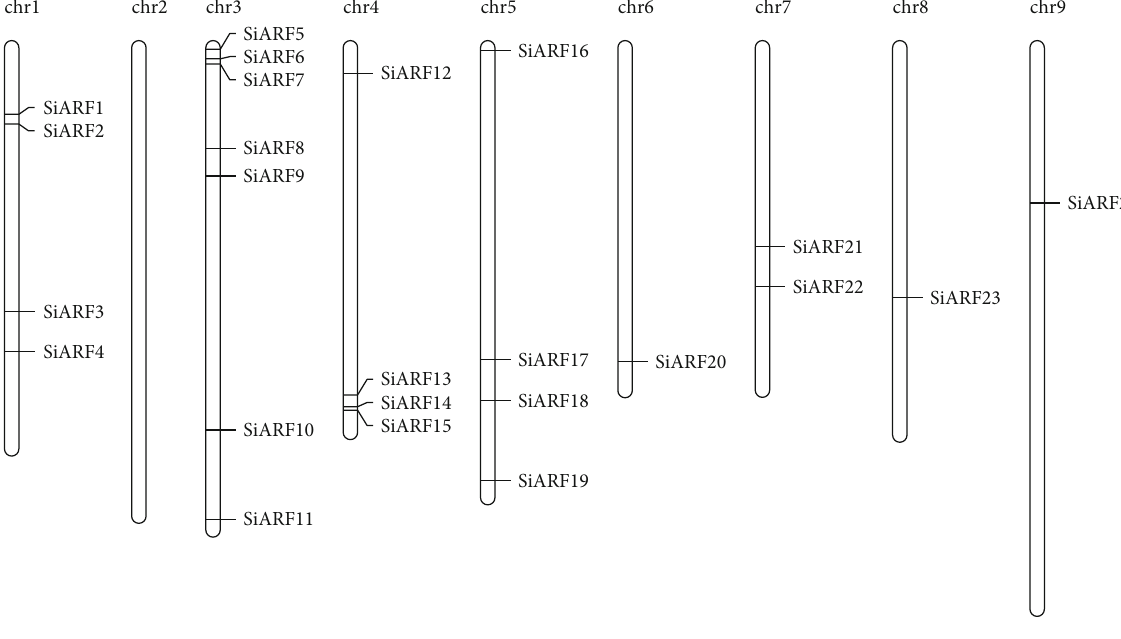
Figure 1: Chromosomal distribution of